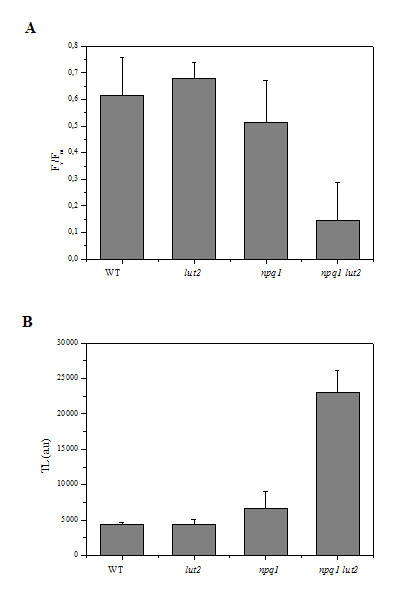
Analyses of the sensitivity to photoxidative stress on WT and mutant genotypes. Whole plants (WT and different mutants) were exposed for 30 hours to a high photon flux density (1100 μmol m-2 s-1) at low temperature (10°C). (A) Measurements of the chlorophyll fluorescence ratio Fv/Fm, an index of photoinhibition of PSII. (B) Analyses of heat-induced luminescence emission of WT and mutant leaves; the 135°C emission band was used as an index of lipid peroxidation and oxidative stress.